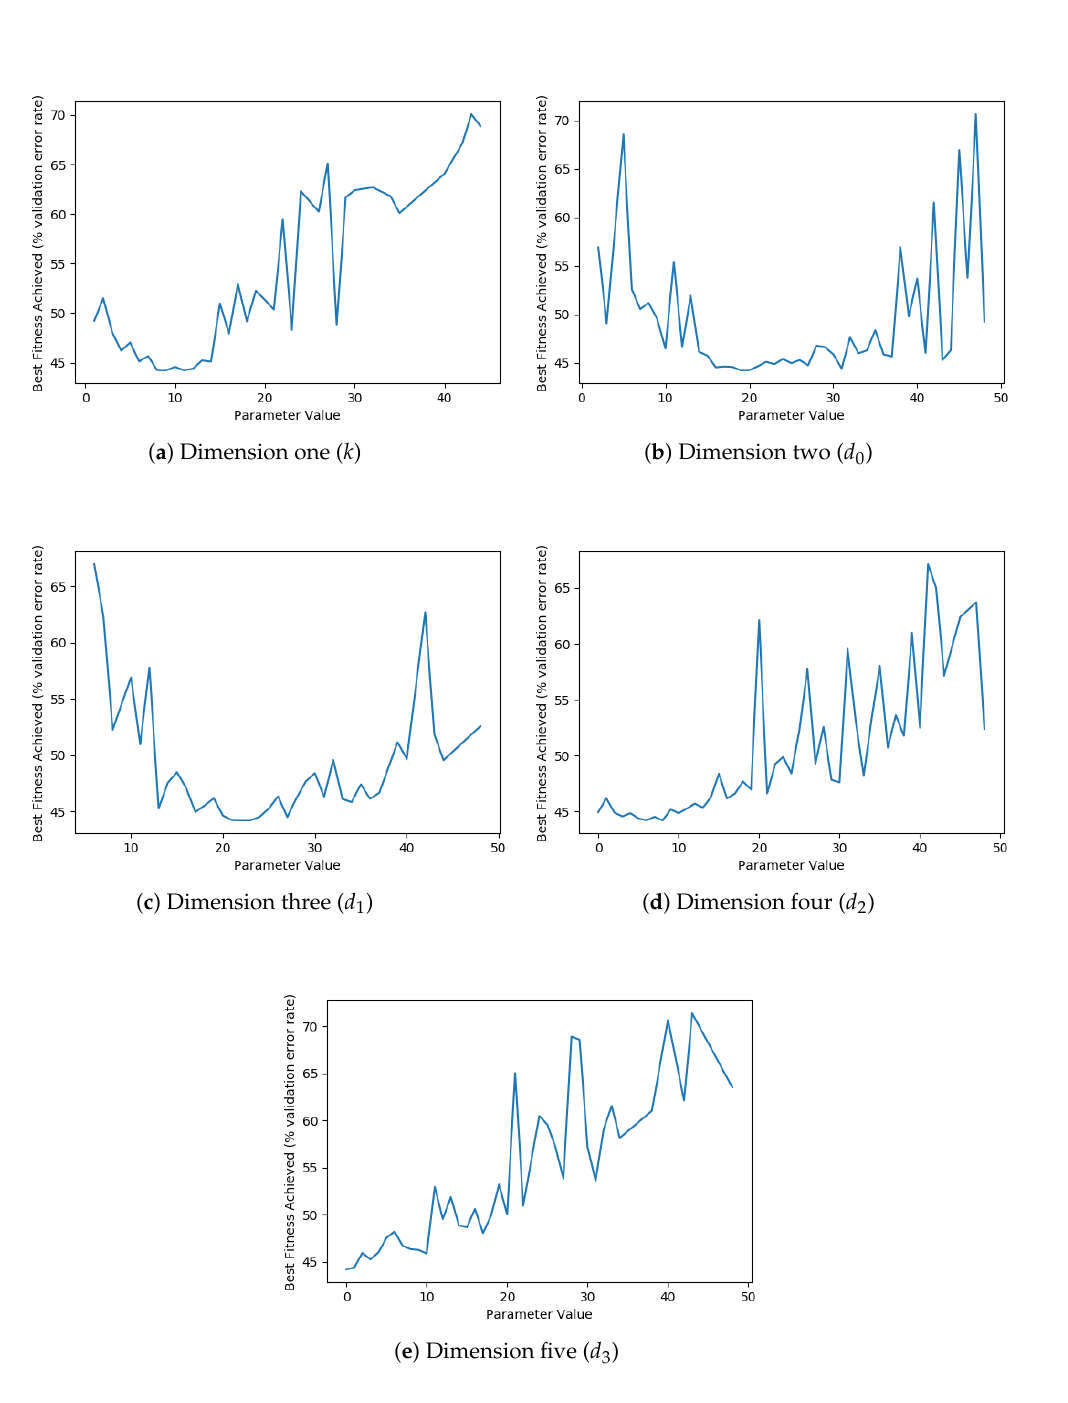
Figure 19. Visualisation of the best fitness scores achieved for different parameter values in each dimension using no weight inheritance